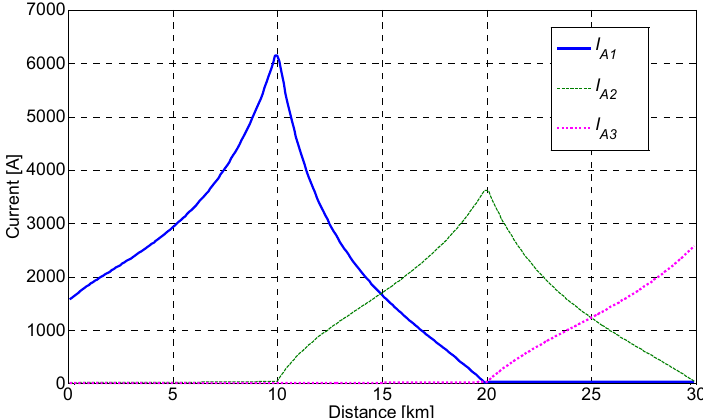
Figure 5. Currents obtained in simulations of the autotransformers ATS1, ATS2 and SATS for different fault locations. Fault between feeder and